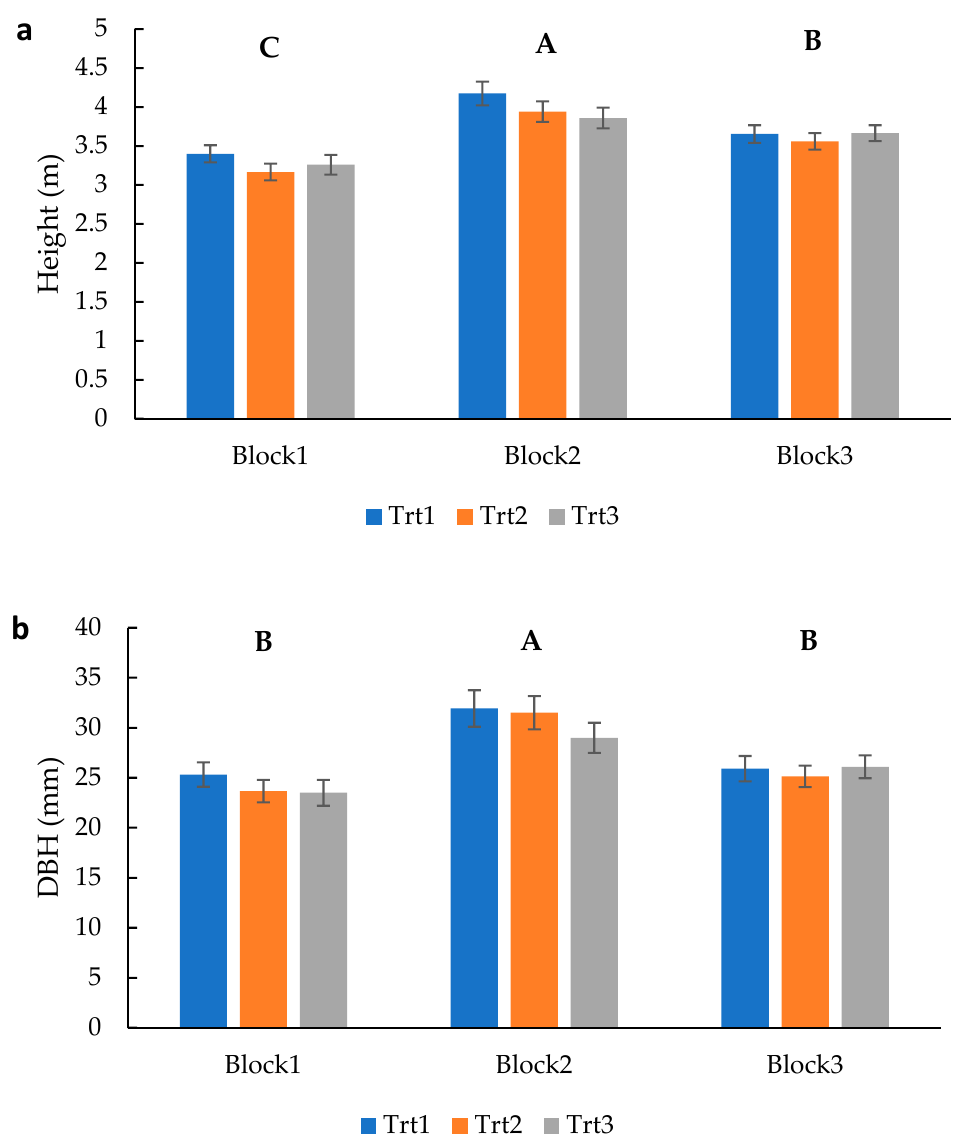
Figure 6. Treatment means (1 = 25 selected tolerant clones, 2 = 10 selected control clones, 3 = Stream 1 vegetative lot clones) of growth parameters for balsam poplar trees planted in three blocks (Block 1 = 5 m from the lake edge; Block 2 = 10 m from the lake edge; Block 3 = 15 m from the lake edge) in 2019. ( a ) Height (m); ( b ) DBH (mm). Significant differences between block means are indicated by different letters. Significant differences between treatment means for height or DBH in each block are indicated by different letters at p ≤ 0.05.